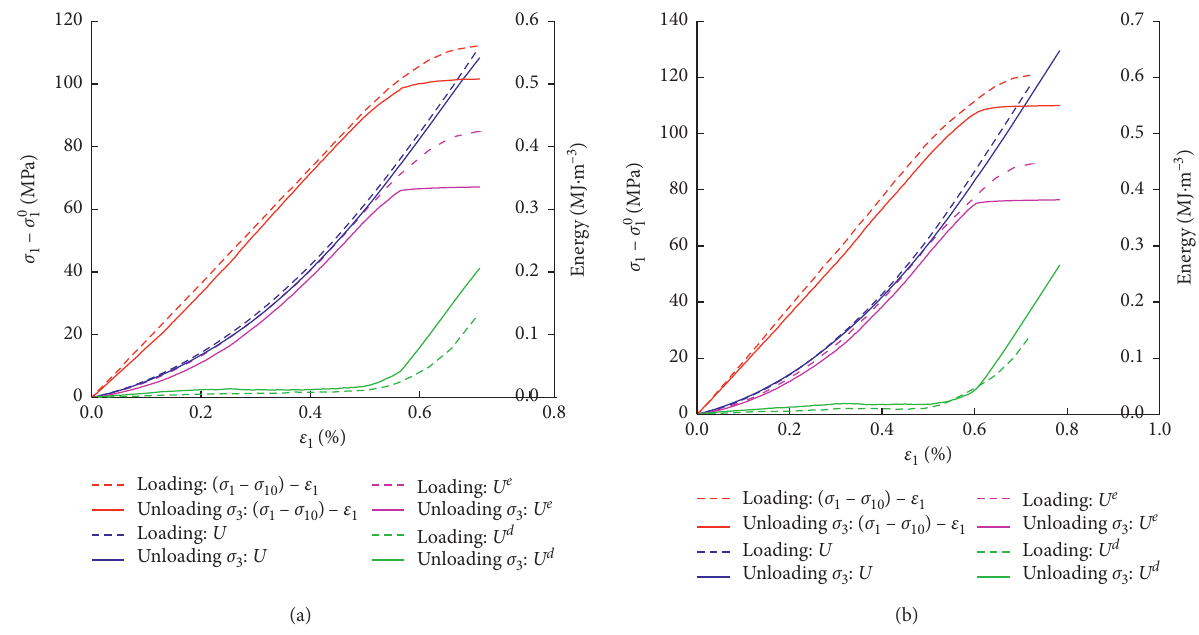
Figure 6: Energy-strain curves. (a) σ